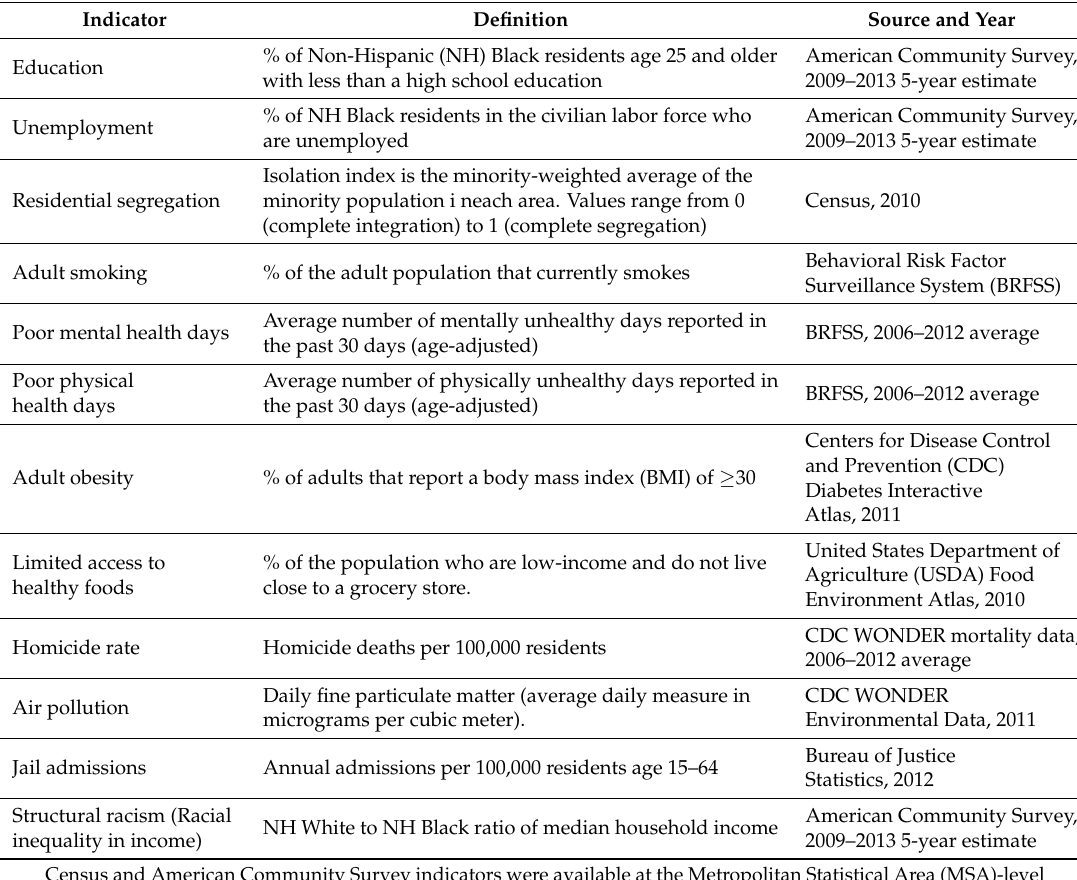
Table 1. Indicator description and data